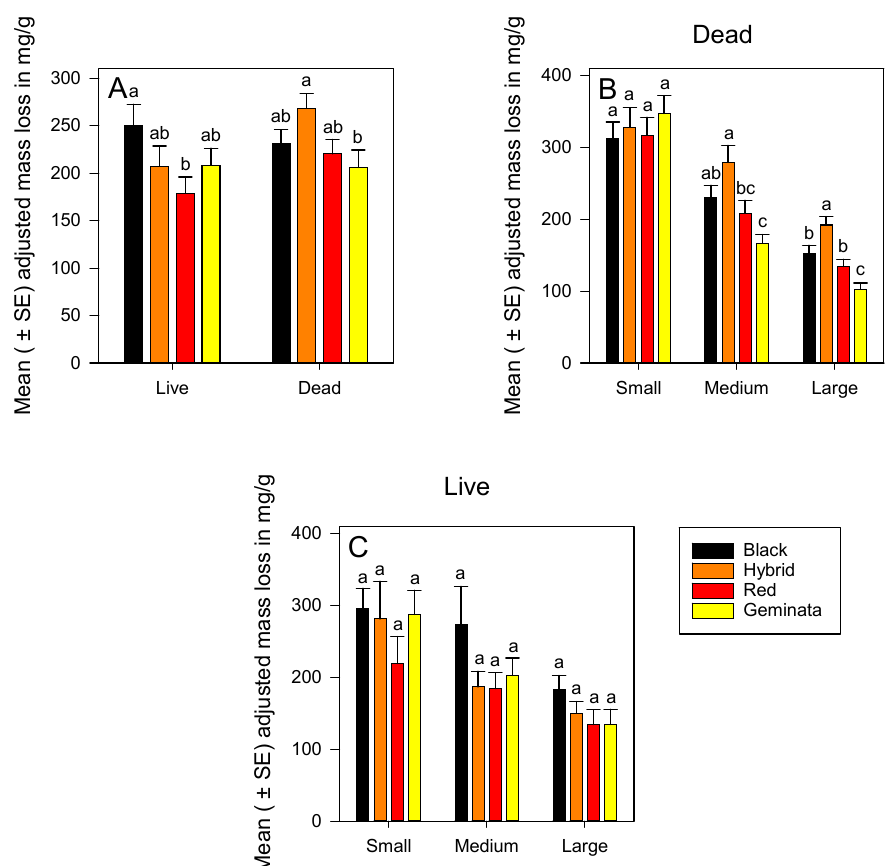
Figure 2. Mean ( ± SE) adjusted mass loss for: ( A ) Combined worker size classes of S . richteri (Black), S . invicta × S . richteri (Hybrid), S . invicta (Red), and S . geminata (Geminata) fire ants compared within each live / dead status; ( B ) Dead S . richteri , S . invicta × S . richteri , S . invicta , and S . geminata fire ants compared within each worker size class; and ( C ) Live S . richteri , S . invicta × S . richteri , S . invicta , and S . geminata fire ants compared within each worker size class. Means with the same letter within each worker size class or species are not significantly di ff erent ( p < 0.05). n = 14 or 15 individuals per worker size class per species.